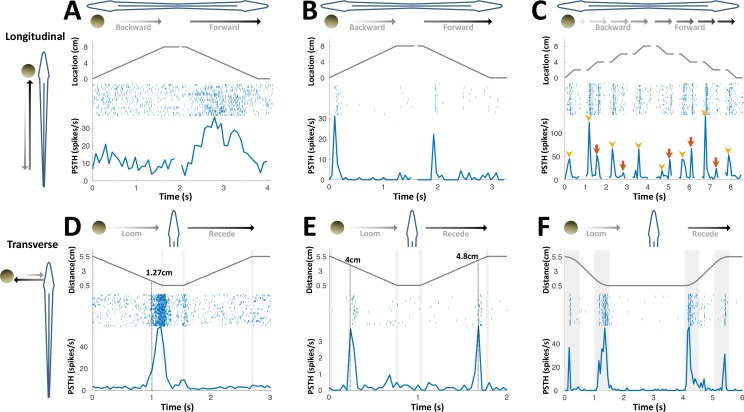
PG cells respond to motion novelty.(A–C) Longitudinal motion. Top: object location (distance from the tip of the nose); middle: spike raster; bottom: PSTH. (A) ‘Atypical’ PG cell responding uni-directionally, throughout the motion toward the head. 43% (3/7) of atypical PG cells responded during forward motion only, while 57% (4/7) responded in both directions. (B) ‘Typical’ PG cell responding to motion-onset at the head during backward motion and to motion-onset at the tail during forward motion. 75% (15/20) of these motion novelty cells respond bi-directionally, 10% (2/20) only during forward motion and 15% (3/20) only during backward motion. (C) PG cell responding to motion onset (yellow arrowheads) and to motion offset (red arrows) in intermittent-motion protocol. (D–F) Responses to transverse (looming-receding) motion. All PG cells recorded with transverse-motion (40/40) responded to object looming, while only 40% (16/40) responded to receding. Top: object distance from skin; middle: spike raster; bottom: PSTH. Grey shadings mark acceleration/deceleration. (D) Proximity detector cell. Note that the response starts prior to the deceleration (shaded). (E) Encounter detector cell. (F) Motion change detector cell, responding when objects accelerated/decelerated (shaded, 10 cm/s2 in this example) similarly to the response observed to longitudinal motion (panels B and C).